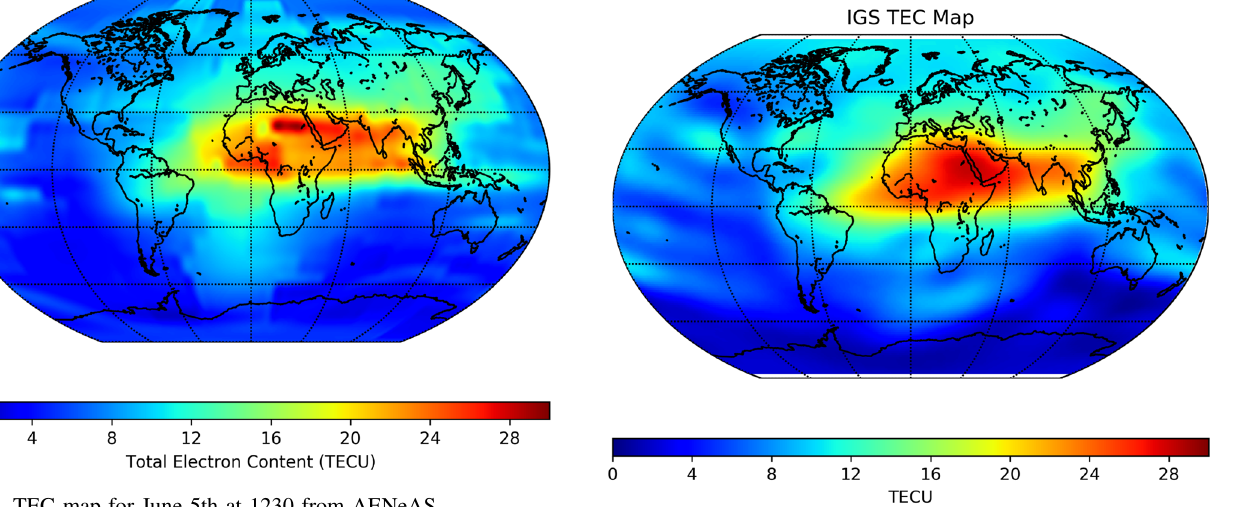
Fig. 6. TEC map for June 5th at 1230 from the IGS Global